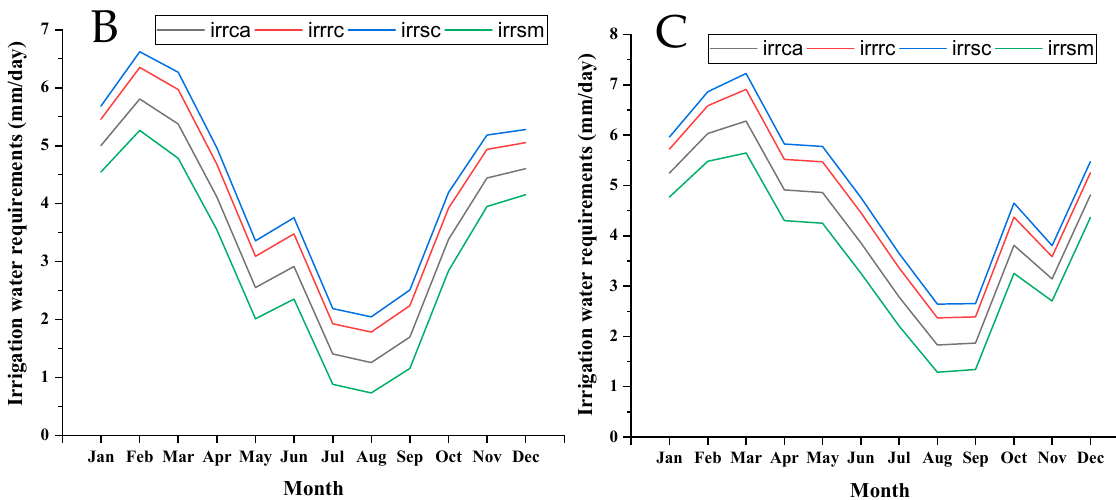
Figure 7. Evolution of IWR (in mm/day) under ECHAM RCP 4.5. ( A ) Demonstrates annual irrigation water requirements. ( B ) Demonstrates monthly irrigation water requirements for 2041 with the lowest irrigation water requirements by crops. ( C ) Demonstrates monthly irrigation water requirements for 2063, with the highest irrigation water requirements by crops. Same as Figure 3.